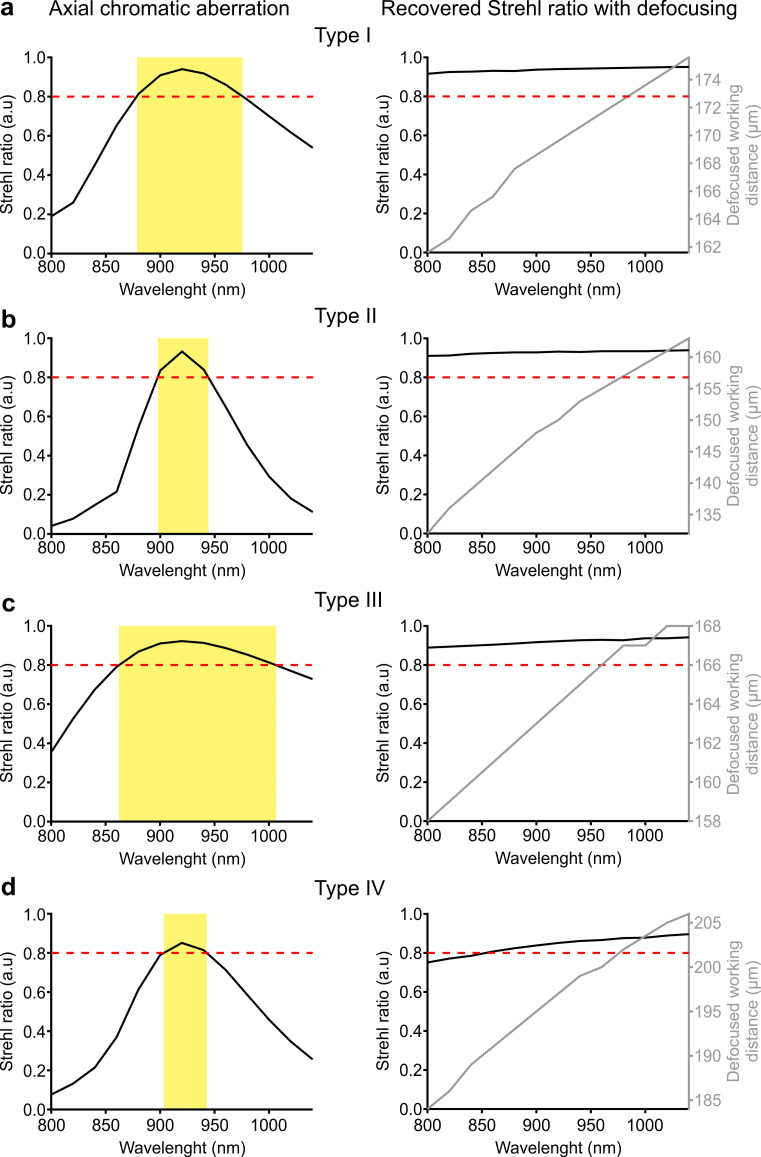
Chromatic aberrations in eFOV-microendoscopes.(a) Left panel: Simulated Strehl ratio at the border of the FOV as a function of wavelength. The red dashed line represents the diffraction-limited condition, which was set at 80% (Maréchal criterion). The yellow area indicates the wavelength range that satisfies the Maréchal criterion. Right panel: highest simulated Strehl ratio (black line) at the border of the FOV and corresponding defocused working distance (gray line) as a function of wavelength. The red dashed line indicates the diffraction-limited condition as in the left panel. (b) Same as in (a) for type II microendoscopes. (c) Same as in (a) for type III microendoscopes. (d) Same as in (a) for type IV microendoscopes.Figure 2—figure supplement 4—source data 1.Simulated Strehl ratio as a function of wavelength.